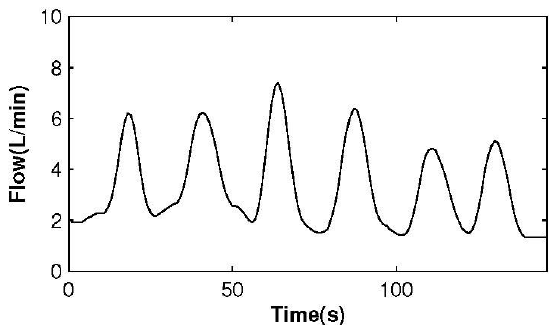
Figure 14. Respiratory flow signal.